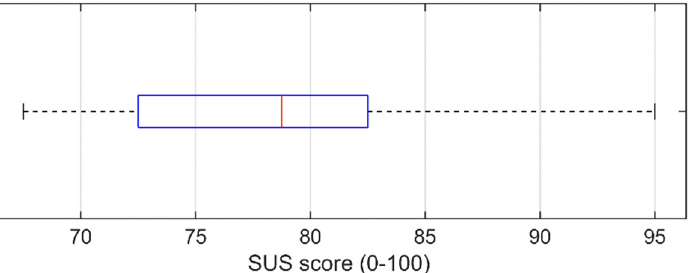
Figure 12. Boxplot representing the final SUS score obtained by the component. The average SUS score was 79.25.